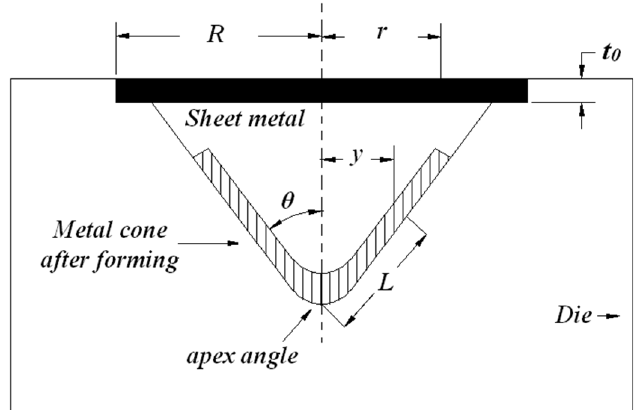
Fig. 6. schematic for forming circular sheet metal into a